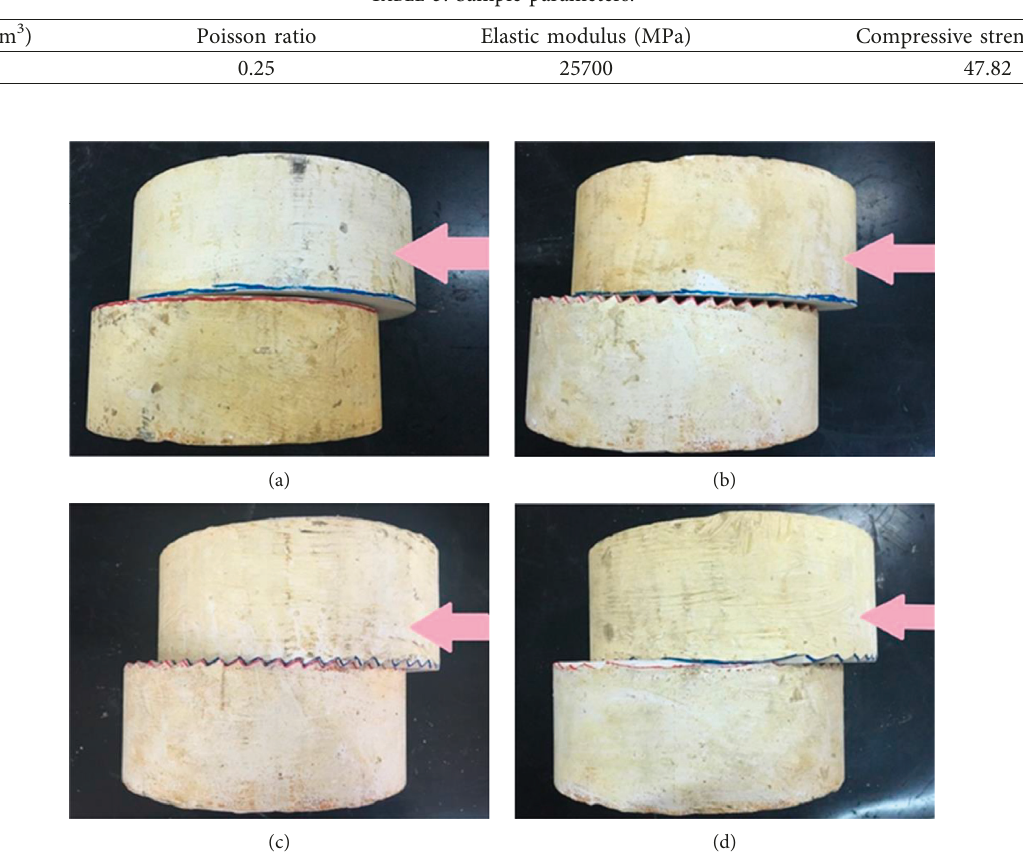
Figure 5: Rock-like sample combinations. (a) I. (b) II. (c) III. (d) IV.